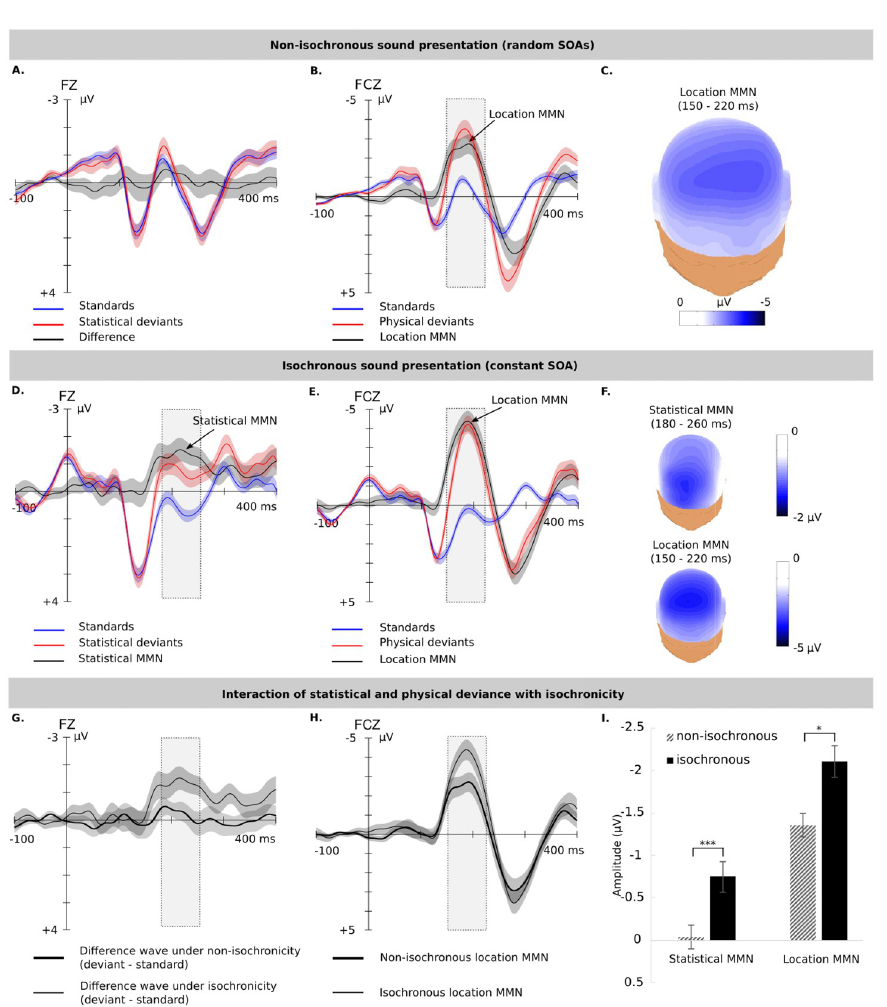
Fig 2. ERPs of statistical and physical deviants as recorded in the current study with non-isochronous sound presentation, and in the previous study [25] with isochronous sound presentation. (A) Mean ERP waves for standards and statistical deviants and the difference (no sMMN) under non-isochronous as recorded at electrode Fz. The shaded area on the ERPs represents the SEM. (B) Mean ERP waves for standards and physical deviants, as recorded from the electrode FCz. The dotted rectangle indicates the time-window for statistical analysis (150–220 ms). (C) Isopotential map showing the scalp distribution of the location MMN over the time-window (150–220 ms). (D) The sMMN under isochronous (high temporal predictability) stimulation as captured at electrode Fz. The dotted rectangle indicates the time-window for statistical analysis (180–260 ms). (E) The location MMN under isochronous stimulation as captured at electrode FCz. (F) Isopotential maps showing the scalp distribution of the sMMN over the window (180–260 ms) and the location MMN over the window (150–220 ms). (G) Separate traces for the differences to statistical deviants under isochronous and non-isochronous stimulation as captured at electrode Fz. (H) Separate traces for the location MMN under isochronous and non-isochronous stimulation as captured at electrode FCz. (I) Both sMMN and location MMN amplitudes decline significantly under non-isochronous